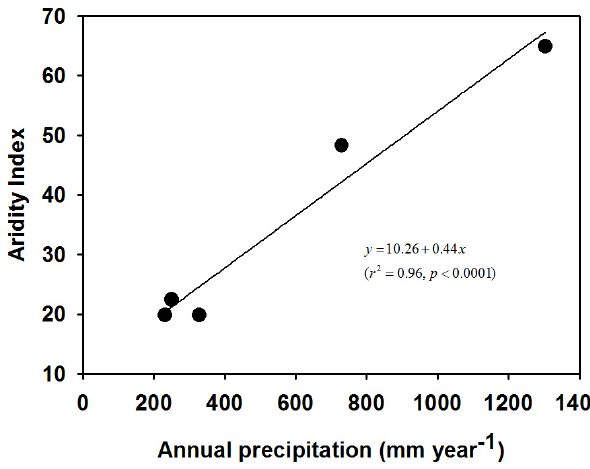
Figure 2. Correlation between annual precipitation and aridity index.